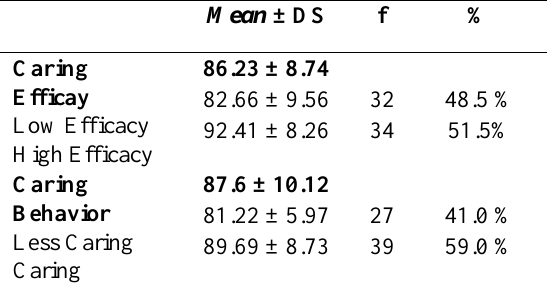
Table 2. The Mean of Nurse Caring Efficacy and Nurse Caring Behavior Score in Taking Care of Critical Patients (n = 66)